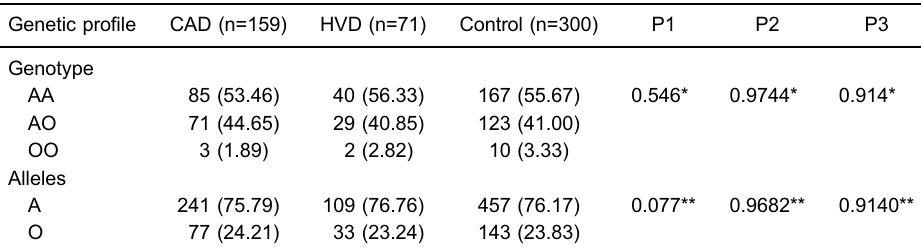
Table 1. Distribution of genotype and allele frequencies in patients with coronary artery disease undergoing coronary artery bypass surgery (CAD), patients with heart valve disease undergoing valve replacement (HVD), and a control group.